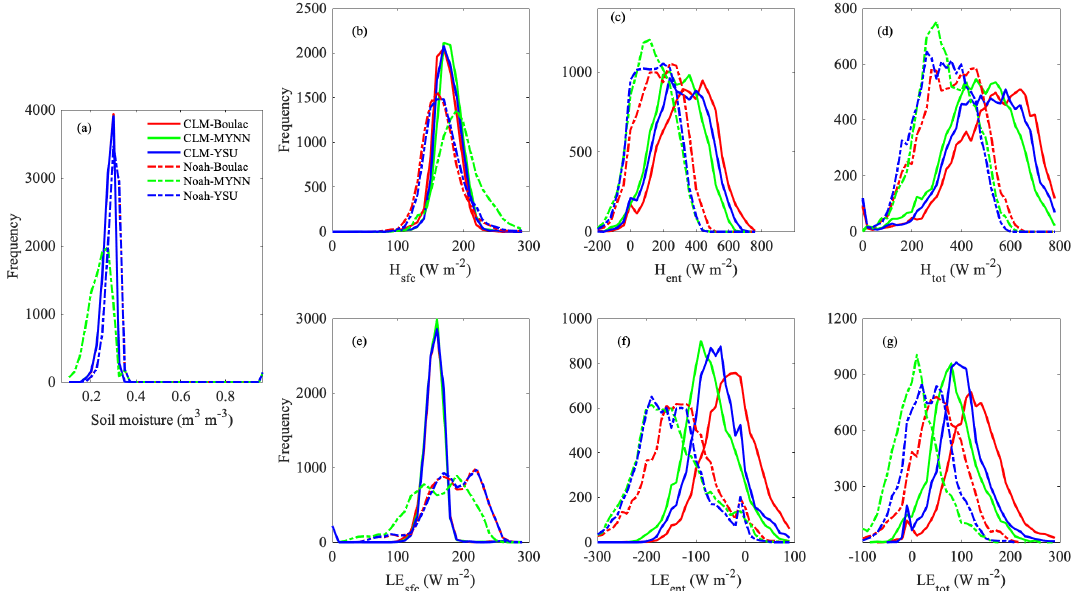
Figure 7. Frequency distribution of (a) mean soil moisture at 0–10cm. (b–g) PBL energy budgets on 7 August 2011. Simulated using different combinations of LSM and PBL schemes.